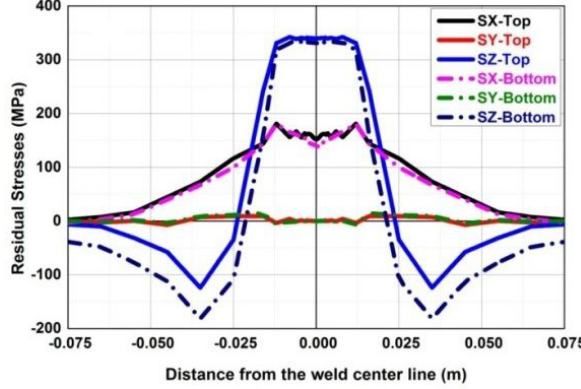
Figure 8: Simulated welding residual stresses at mid span of weld centre line – Fully constraint at nodes from 45 mm (Case